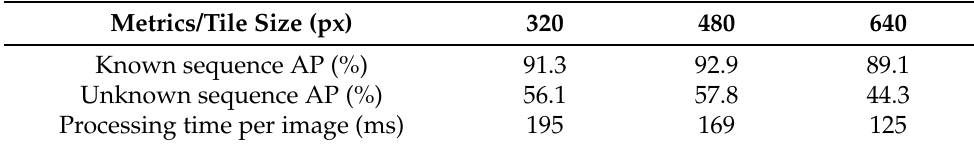
Table 1. Impact of tile resolution on detection performances and processing time per image evaluated on images from a seen and an unseen sequence.